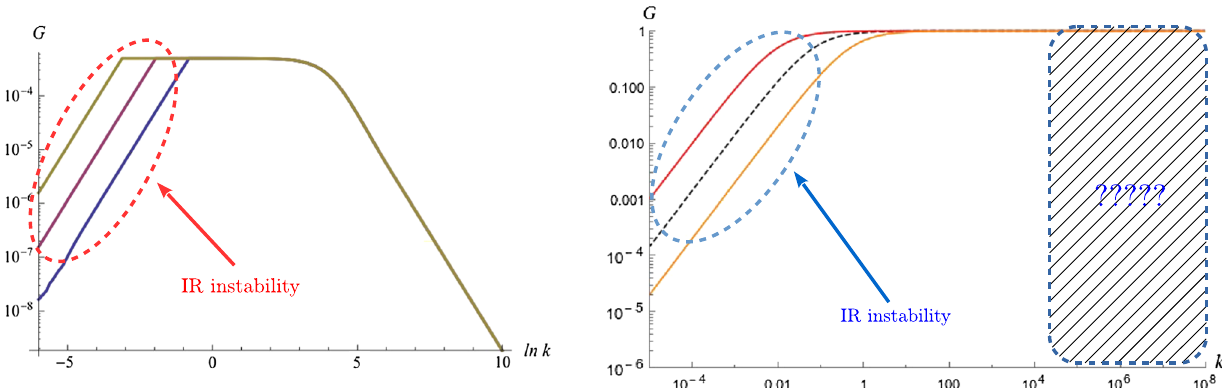
Fig. 1 Left panel: gravitational running coupling G ( ˜ k ) extracted from [97]. An unusual feature in the IR sector is observed. This was called “IR instability” and reveals that some deviation in such sector could appear. Right panel: gravitational running coupling G ( ˜ k ) obtained in our model assuming the replacement ˜ kr = 1. We observe that our solu-